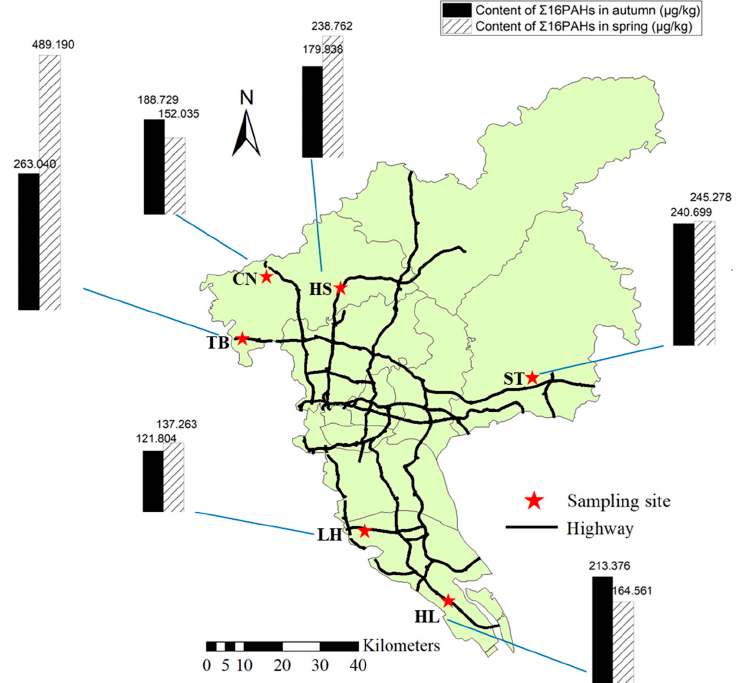
Figure 4. Spatial distribution of PAHs in farmland soil in autumn and